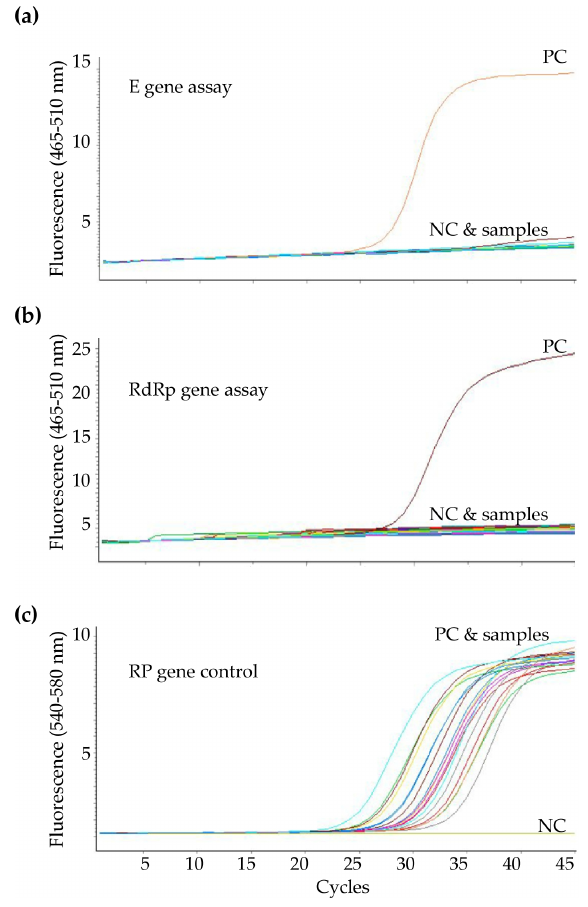
Figure 3. Example for amplification curves of the ( a ) E gene assay and ( b ) RdRp gene assay with ( c ) RP gene assay using the optimized real-time RT-PCR protocol.